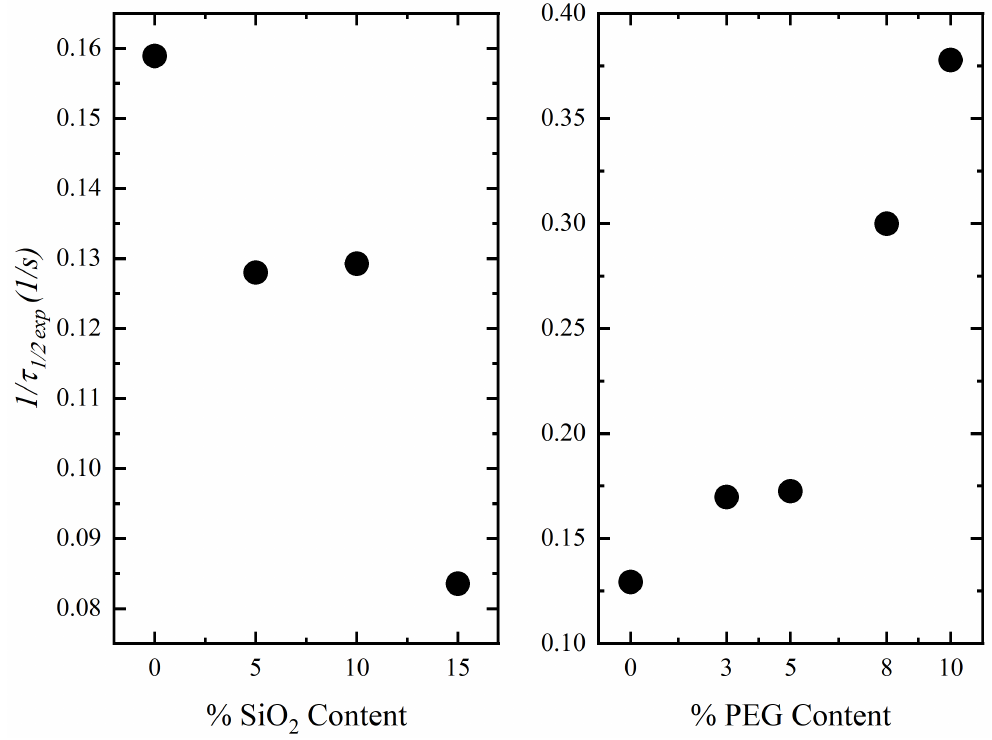
Figure 6. Values of 1/ τ 1/2 exp at 95 °C for PLLA/SiO 2 and 88 °C for PLLA/SiO 2